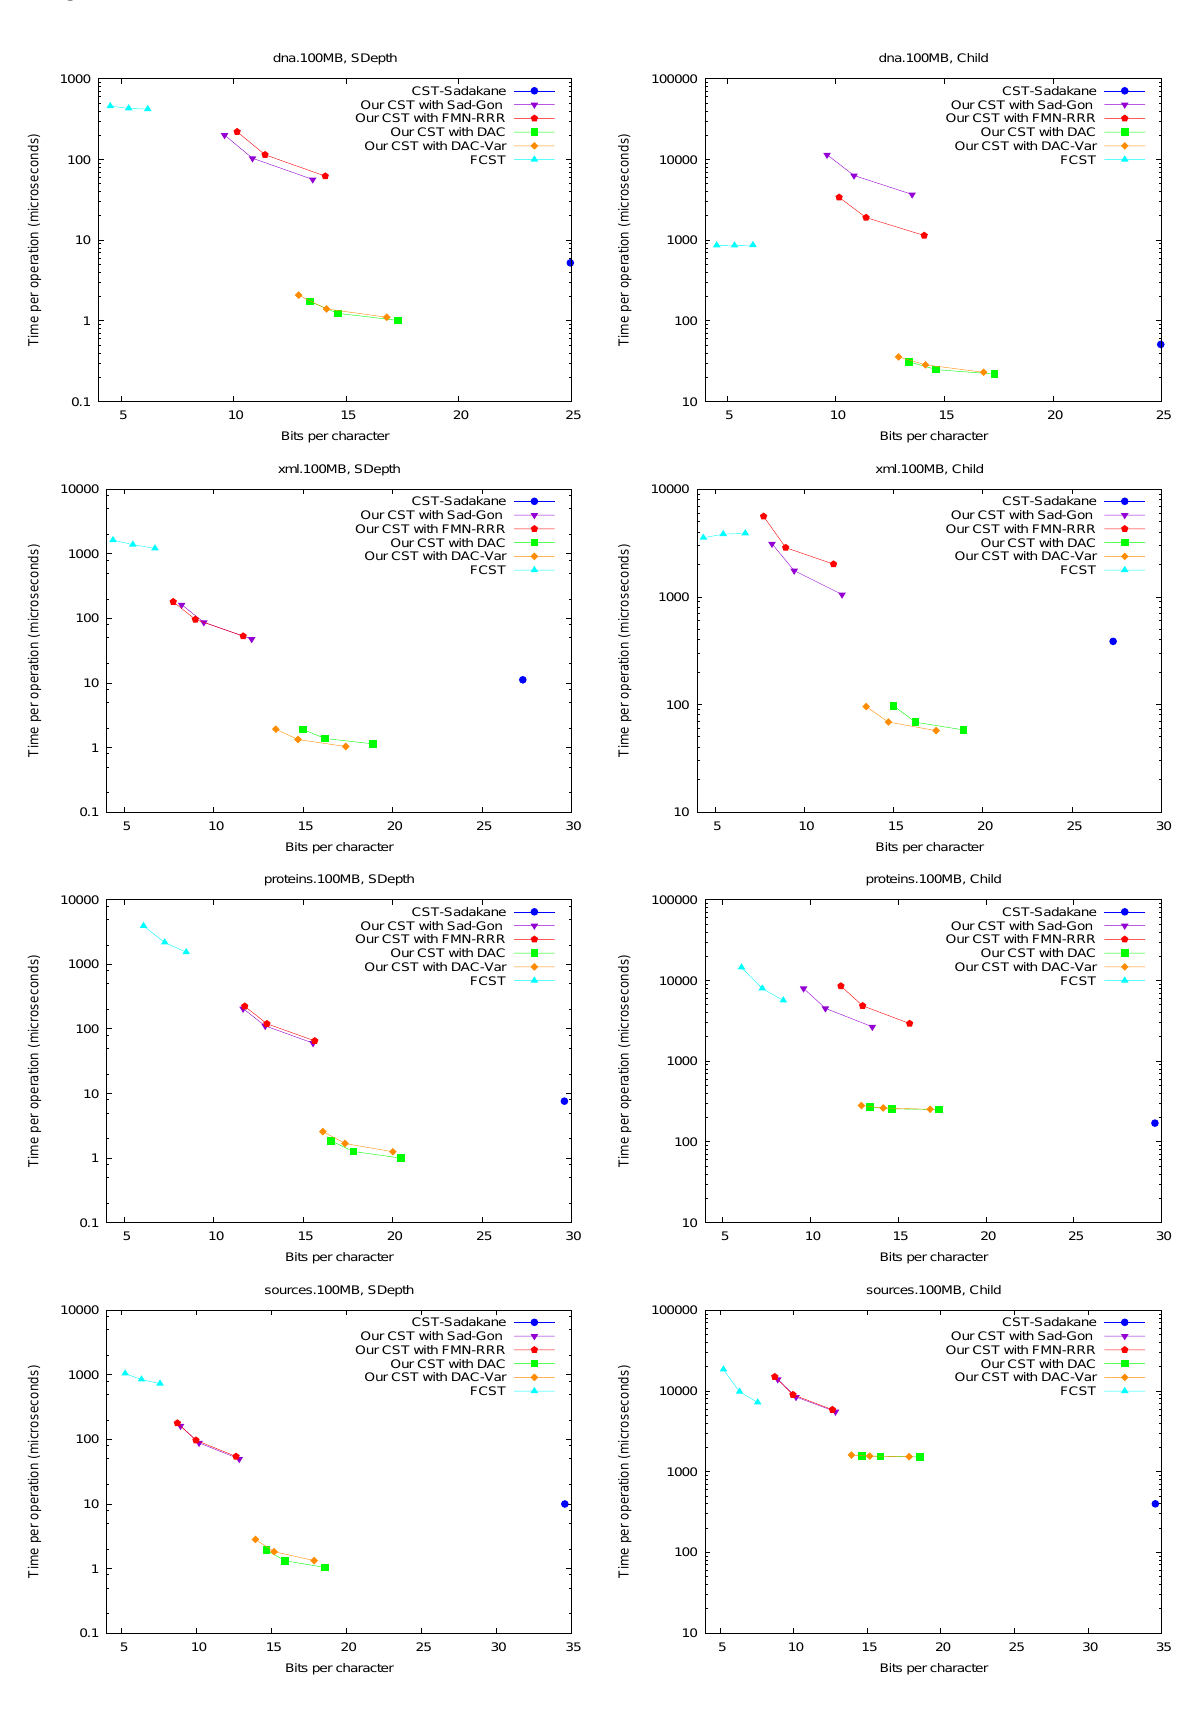
Figure 6. Space/Time trade-off performance for operations SDepth and Child . Note the log